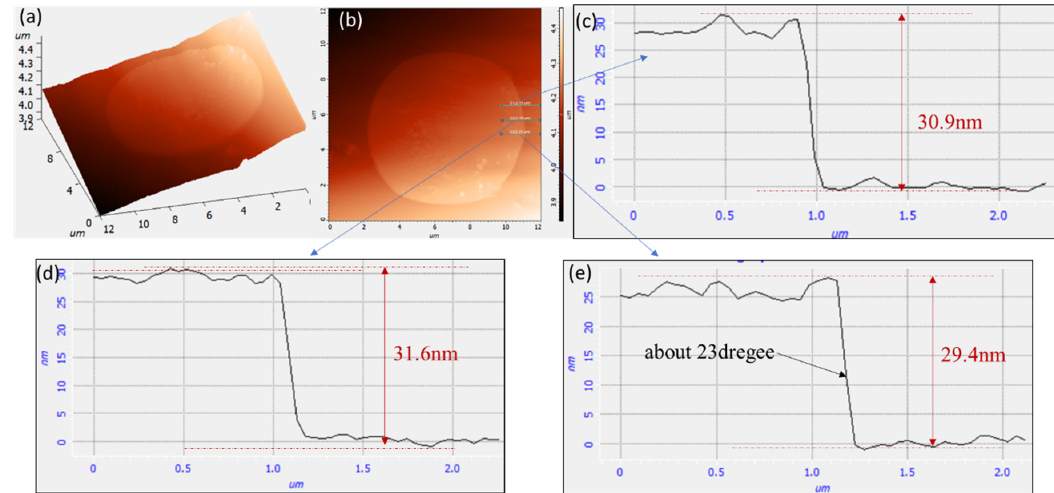
Figure 4. The fabricated graphite nanostructure with about 23 ° sidewall ( a , b )